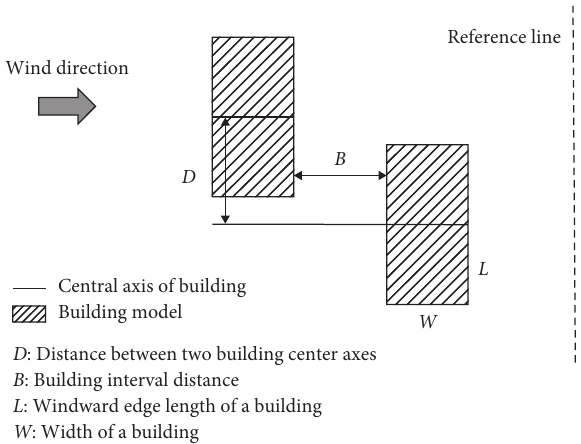
Figure 2: Variables in the basic unit (building